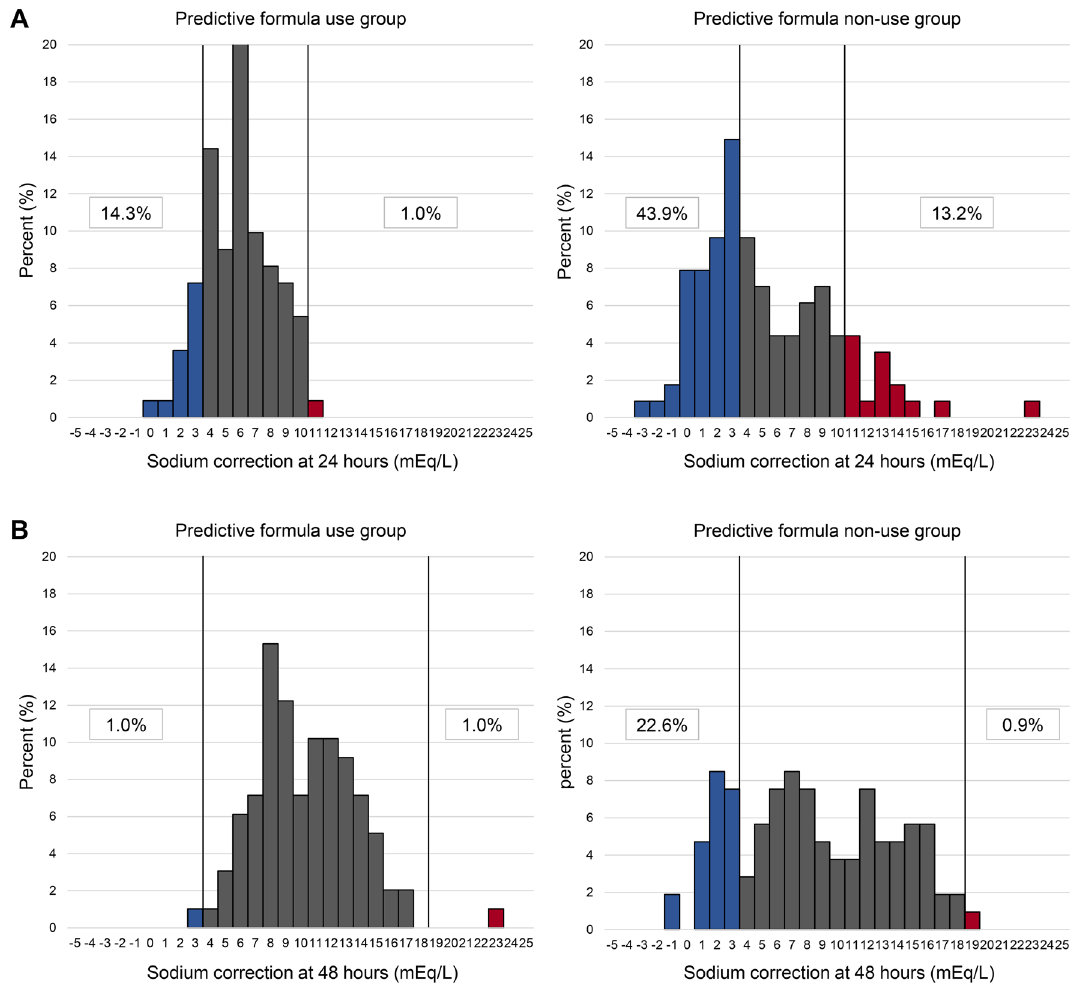
Figure 3. Distribution of the change in the initial serum sodium concentration ≤ 120 mEq/L at baseline to 24 and 48 h ( A and B ) in patients for whom the predictive equation was used and not used, and the percentage of patients with inappropriate